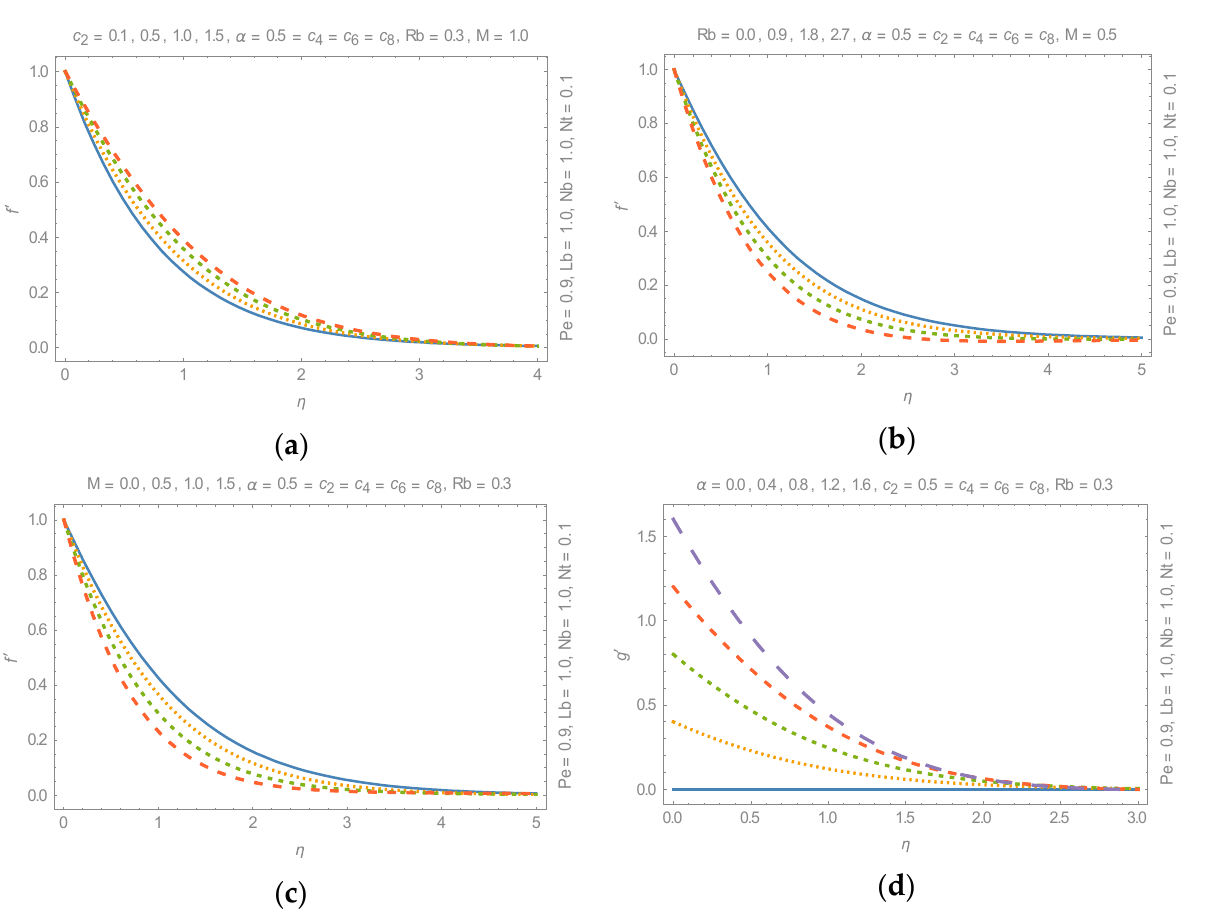
due to no-slip wall conditions.